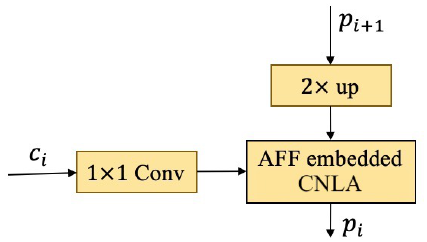
Figure 4. Building block to combine features from down–up and up–down